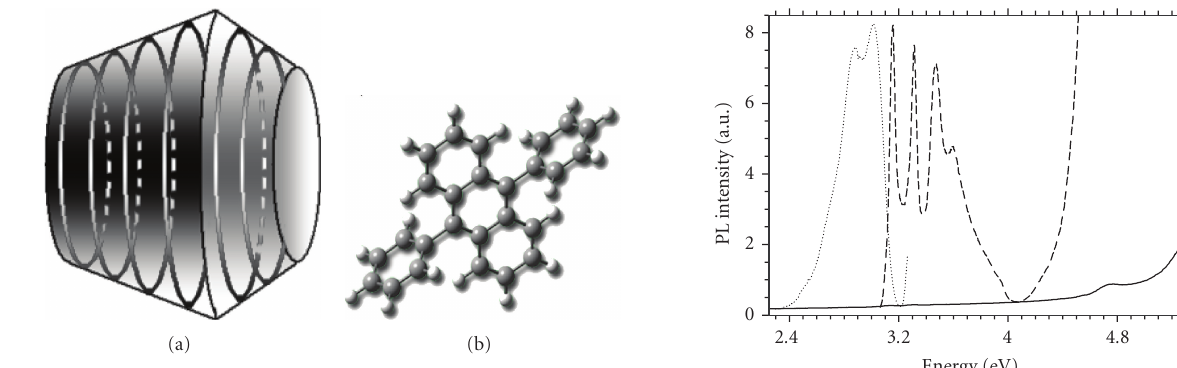
Figure 2: Comparison between optical absorption measurements of an aqueous solution of DPA alone (solid line) and after addition of a sample amount of CTACl (dashed line), along with PL spectrum of the resulting system (dotted line) excited at 3.15